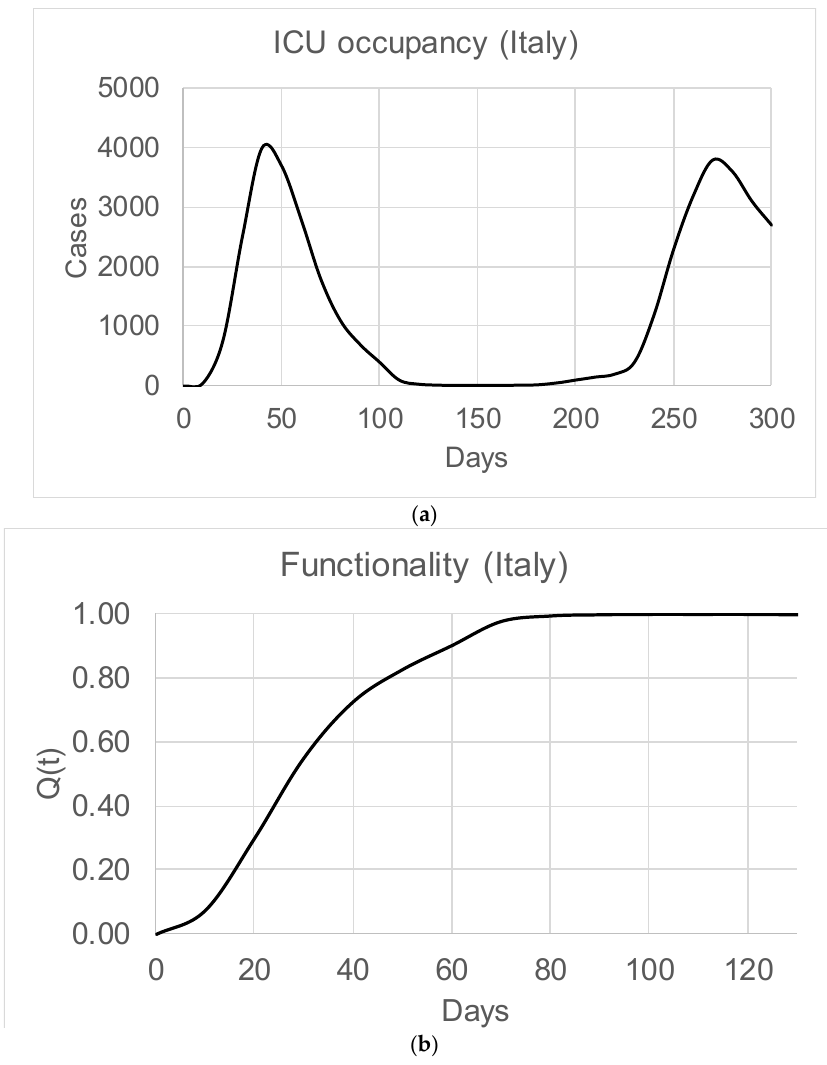
Figure 6. ( a ). Number of COVID-19 patients in ICU in Italy from 18 February 2020 to 3 January 2021. Source: Ministero della Salute/Protezione Civile italiana. ( b ). Health Infrastructure functionality vs. days in Italy (T = 140 days).